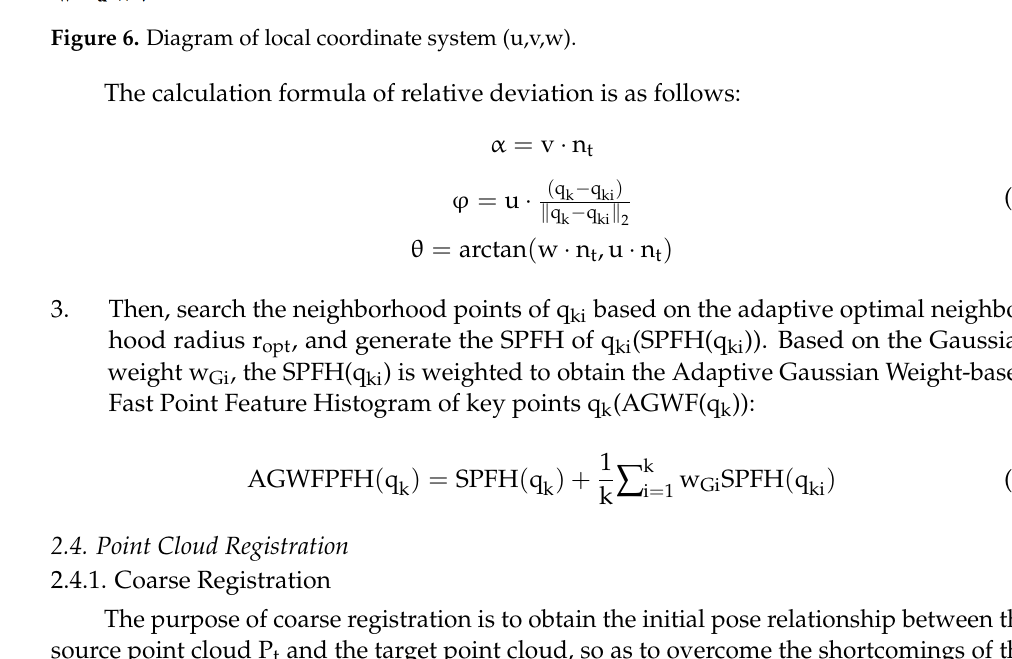
Figure 6. Diagram of local coordinate system (u,v,w).